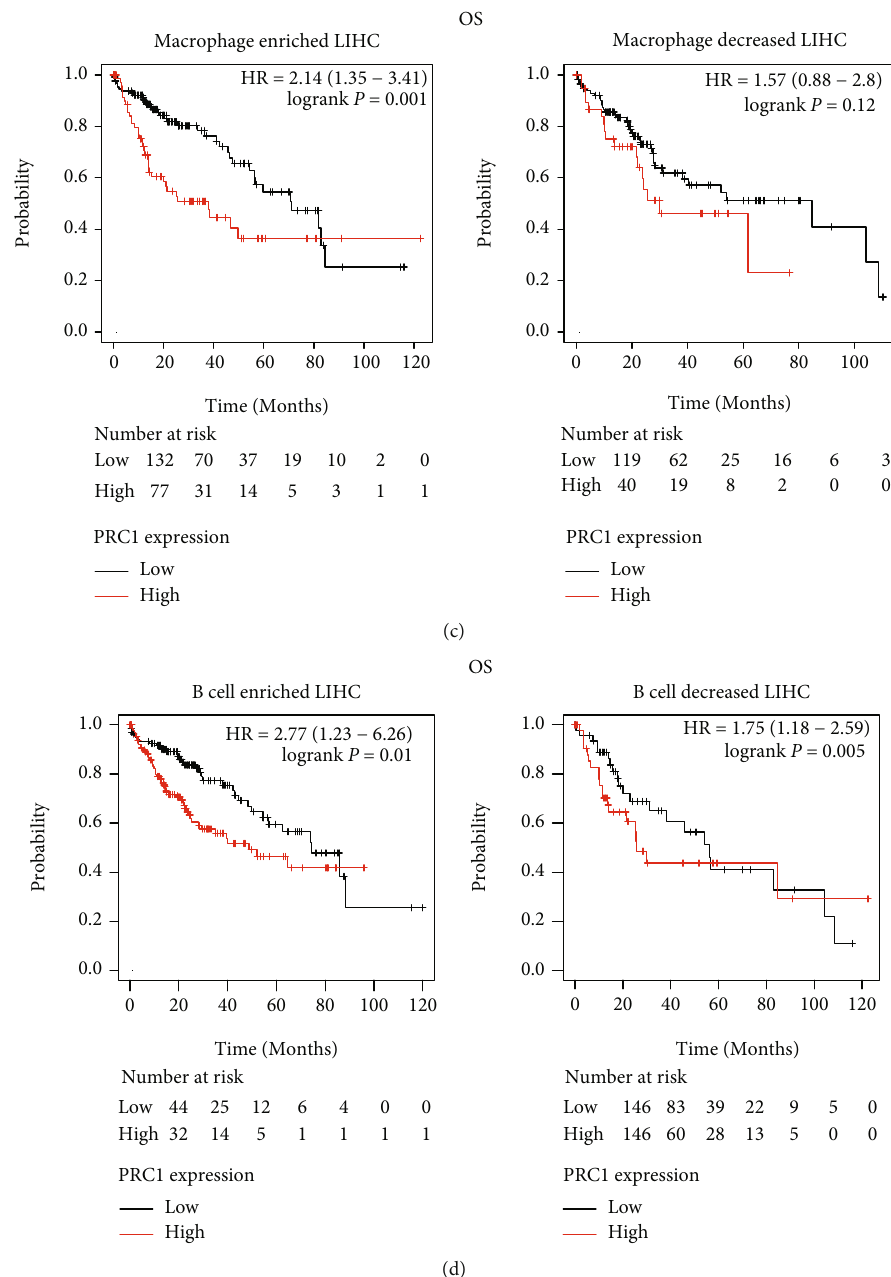
Figure 9: Survival curves according to high and low expression of PRC1 in LIHC grouped by Treg, macrophage, or B cell in fi ltration. Correlation of PRC1 expression and OS (a) and RFS (b) in Treg-enriched and decreased LIHC subgroups were estimated by Kaplan- Meier plotter. OS analyses of PRC1 in LIHC cases grouped by macrophage (c) or B cell (d) in fi